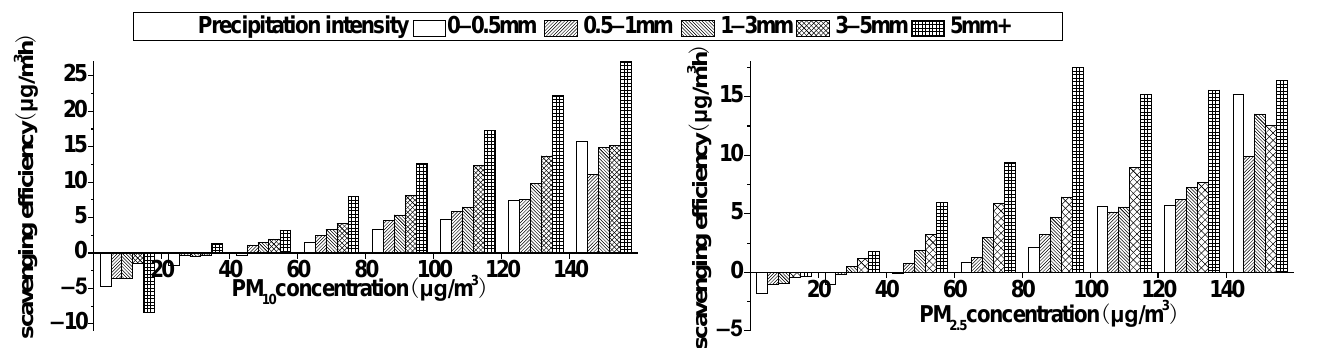
Figure 3. Effects of different rain intensities ( RI s) and particle mass concentrations on scavenging efficiency ( SE ).